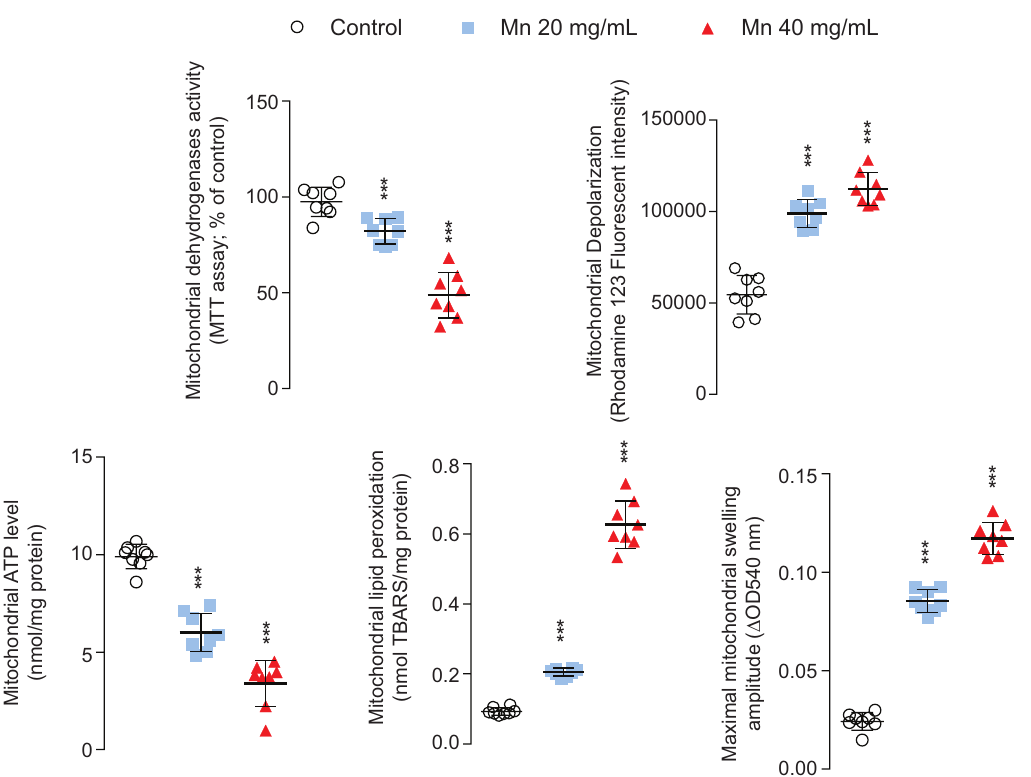
Figure 3 . Markers of mitochondrial impairment in the kidneys of manganese-treated animals. Data are presented as mean ± SD (n = 8). *** Significantly different from the control group (P < 0.001).